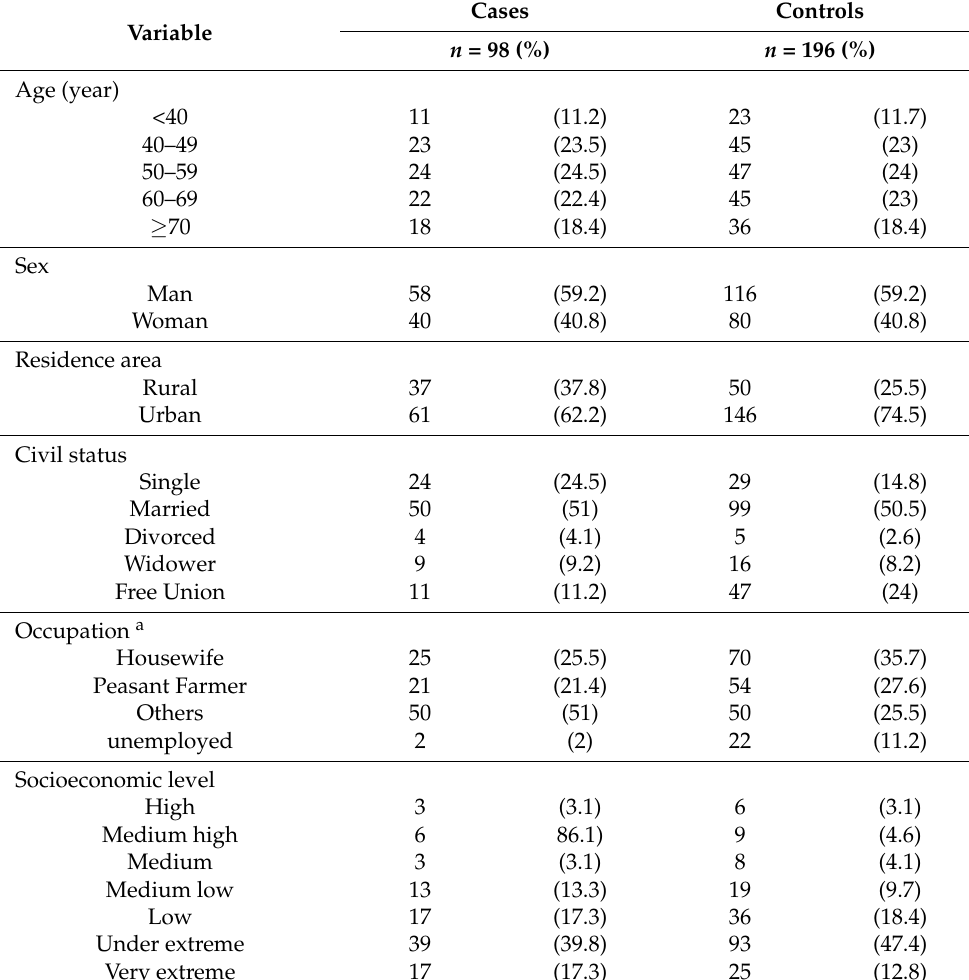
Table 1. Sociodemographic characteristics of the cases and